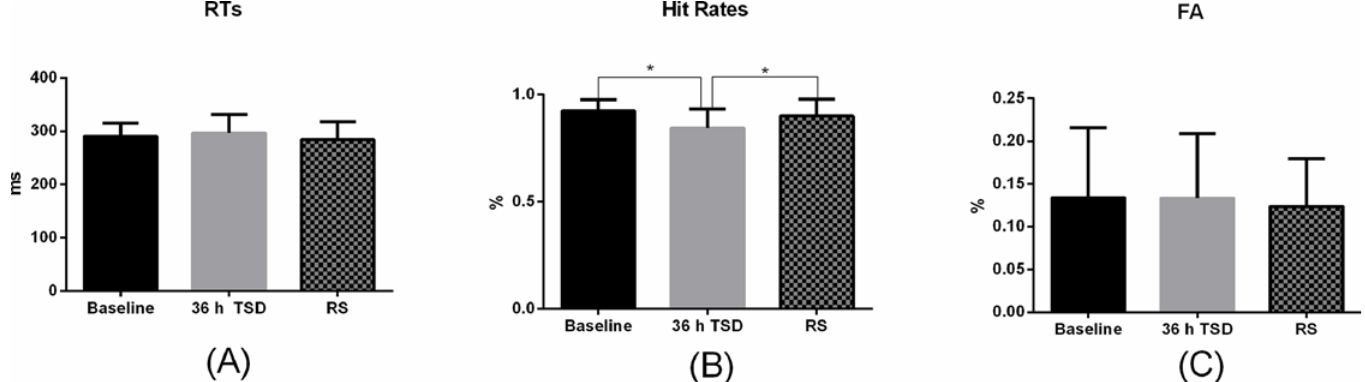
Fig 4. The differences of RT and Hit Rates in Go trials and FA in No-Go trials between Baseline, 36 h TSD and 8 h RS. RTs: The Reaction Time, FA: False Alarms, Baseline: before total sleep deprivation session, 36 h TSD: after 36 hours of total sleep deprivation, 8 h RS: after 8 hours of recovery sleep. (A): The mean of RTs in Baseline, 36 h TSD and 8 h RS. (B): The mean of Hit Rate in Baseline, 36 h TSD and 8 h RS. (C): The mean of FA in Baseline, 36 h TSD and 8 h RS. The error bars represent standard deviation. * : p < 0.05.